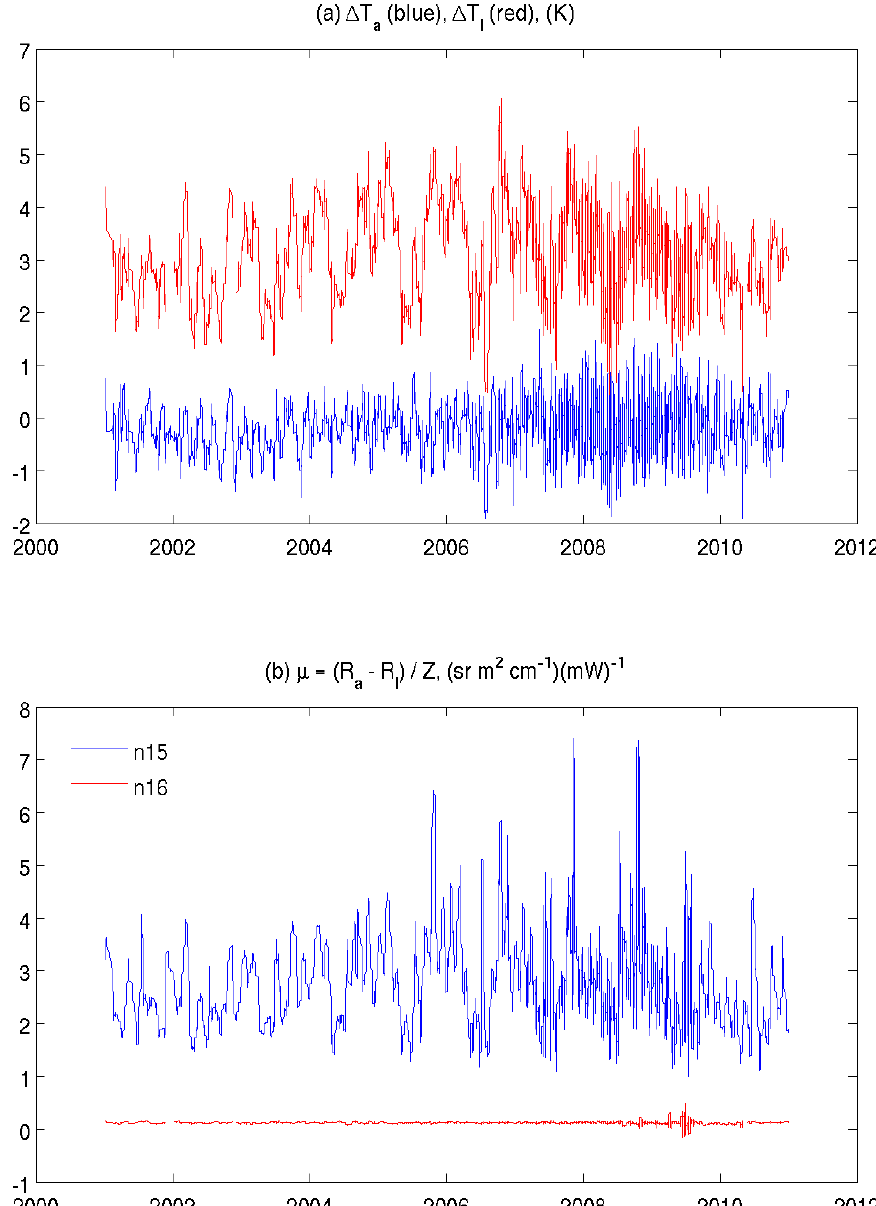
Figure 7. Characterization of the nonlinearity of 89 GHz channel of NOAA-15 from SNO pairs of NOAA-15 and 16. ( a ) T a and T l di ff erence between NOAA-15 and 16. ( b ) µ of NOAA-15 and -16, calculated from Equation (1).